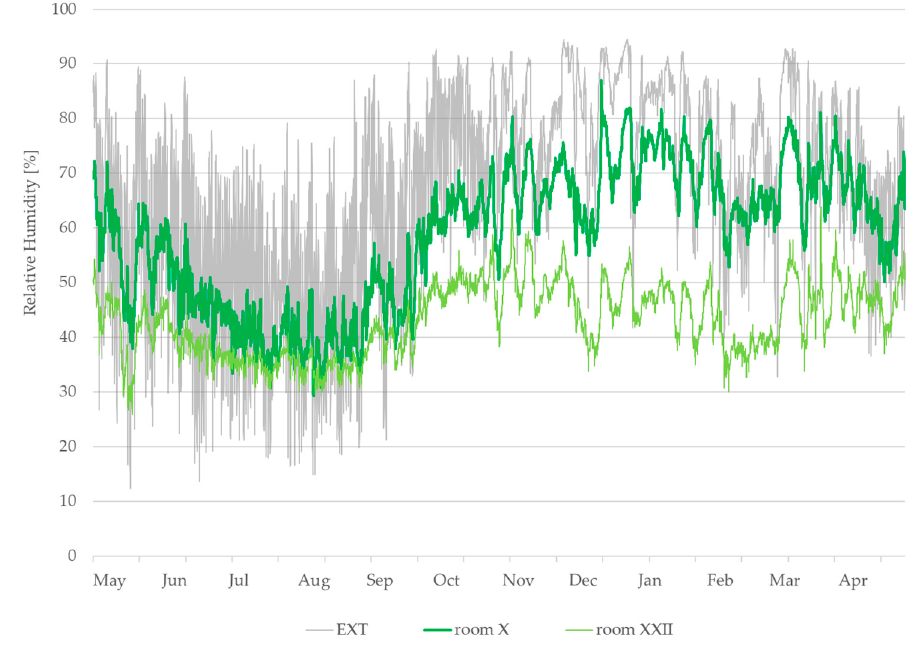
Figure 18. Time profiles of relative humidity RH values measured from May 2012 to April 2013 in rooms X and XXII, and outdoors (EXT).